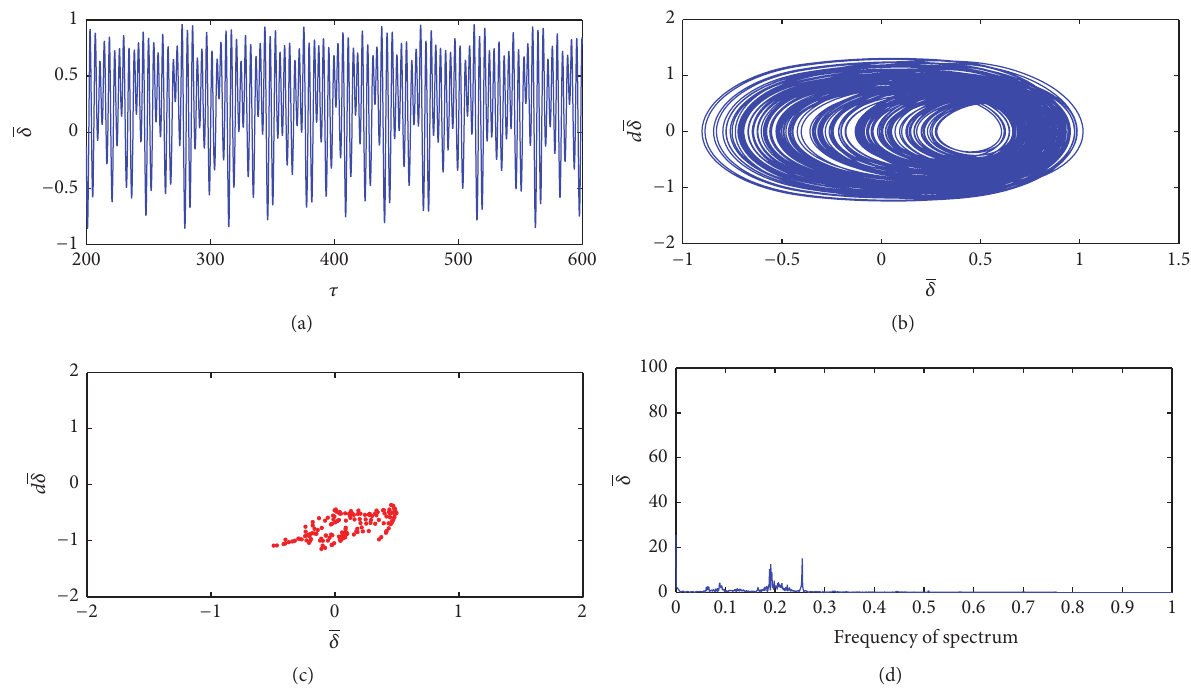
Figure 4: 𝜔 ℎ = 1.6: (a) time history; (b) phase plane; (c) Poincar´e map; (d) Fourier spectrum.